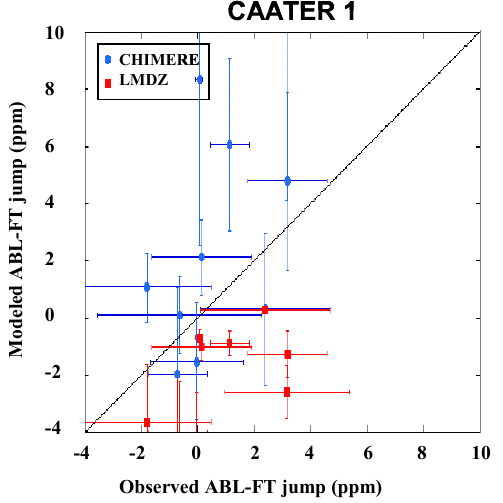
Fig. 3. Comparison of the modelled ABL-FT jumps from LMDZ- ORCHIDEE and CHIMERE-ORCHIDEE to the observed jumps for CAATER 1. Points represent the mean jump for each profile and bars represent the associated ± 1- σ standard deviation.